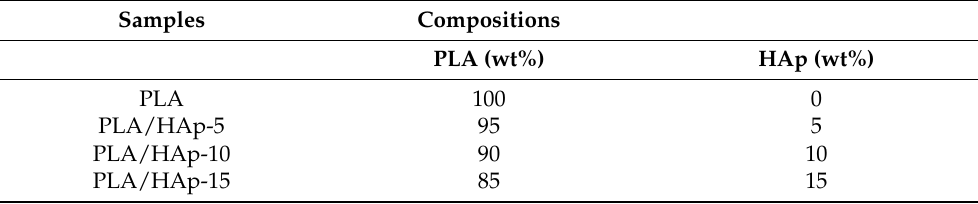
(Table 1), using the following processing conditions: mixing temperature = 180 ◦ C, screw speed = 50 rpm and residence time = 8 min. Table 1. Code and composition of the various formulas elaborated by melt